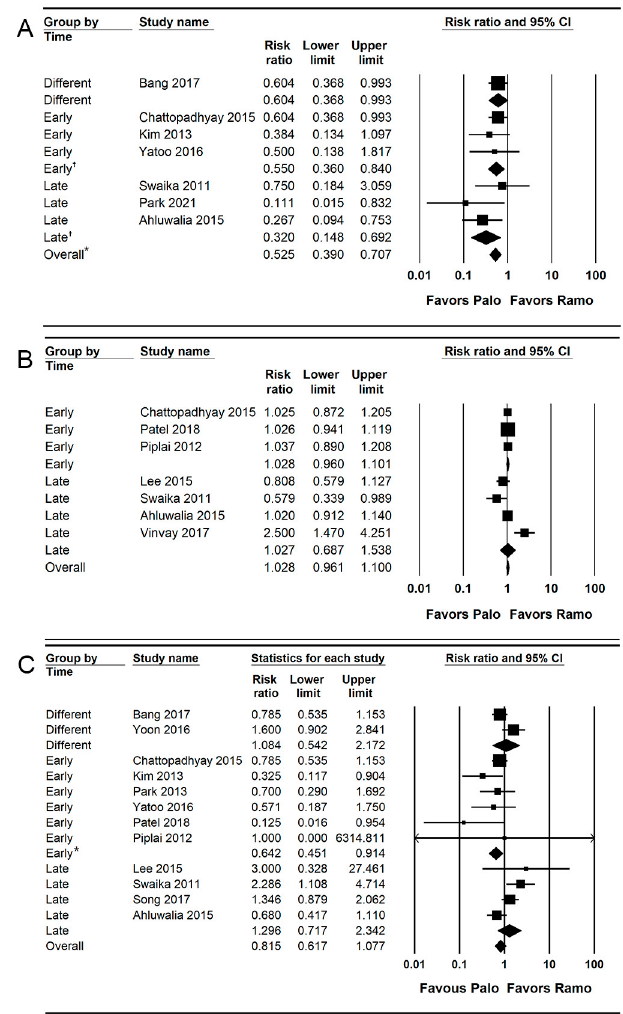
Figure 6. Forest plot of studies comparing the effectiveness of palonosetron with that of ramosetron on ( A ) retching, ( B ) complete response, and ( C ) use of rescue antiemetics. The diamond shape depicted the pooled estimates and uncertainty of the combined effect. The combined results showed no evidence of differences between palonosetron and ramosetron for the complete response and use of rescue antiemetics. On the other hand, palonosetron was more effective than ramosetron in preventing retching (*). For subgroup analysis, no evidence of differences was observed between palonosetron and ramosetron for the complete response according to administration time. Whereas, the pooled estimates demonstrated that palonosetron was more effective than ramosetron in the prevention of retching when they were administered early and late (†) and in the use of rescue antiemetics when they were administered early (*).